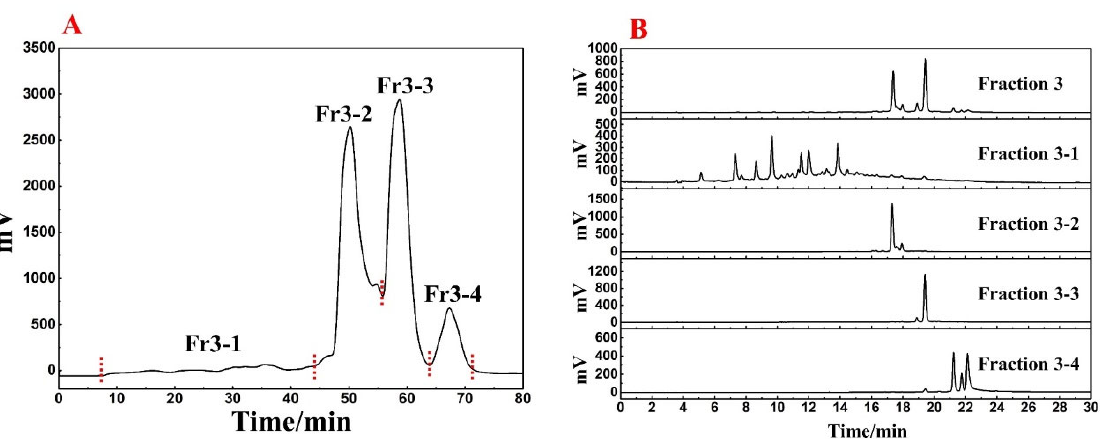
Figure 2. ( A ) Spherical C18-MPLC separation chromatogram of Fr3. ( B ) Comparative chromatogram of Fr3 and each fraction after pretreatment.